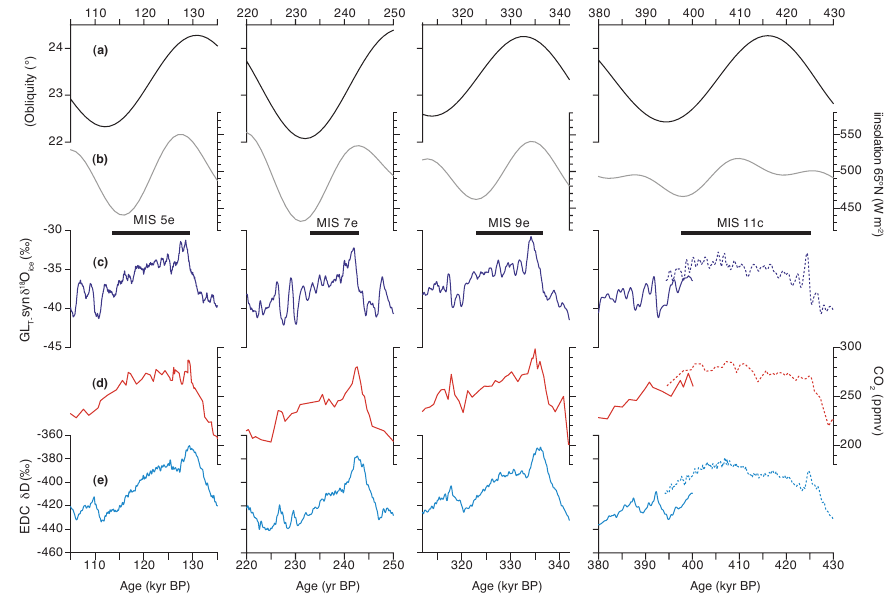
Fig. 3. Astronomical parameters and palaeoclimatic records for the interglacials corresponding to MIS 5e, 7e, 9e and 11c. Thick horizontal bands indicate estimated interglacial duration (see text). (a) obliquity (Laskar et al., 2004); (b) 21 June insolation 65 ◦ N (Laskar et al., 2004); (c) Reconstructed δ 18 O composition of ice in Greenland synthetic (GL T − syn) record (Barker et al., 2011); (d) atmospheric CO 2 concentration in Antarctic ice cores (L¨uthi et al., 2008); (e) δ D composition of ice in the EDC ice core (Jouzel et al., 2007). Palaeoclimate records from the interval 0–400kyrBP are plotted on the GL T − syn timescale based on alignment to Chinese speleothem records (Barker et al., 2011). As this does not extend to the base of the MIS 11c, records from the early part of the interglacial (dotted lines) are plotted on the EDC3 timescale of Parrennin et al. (2007) (see Barker et al., 2011). Thus the timing of the MIS 11c glacial inception is based on the GL T − syn/Chinese speleothem timescale, but the interglacial onset is based on the EDC3